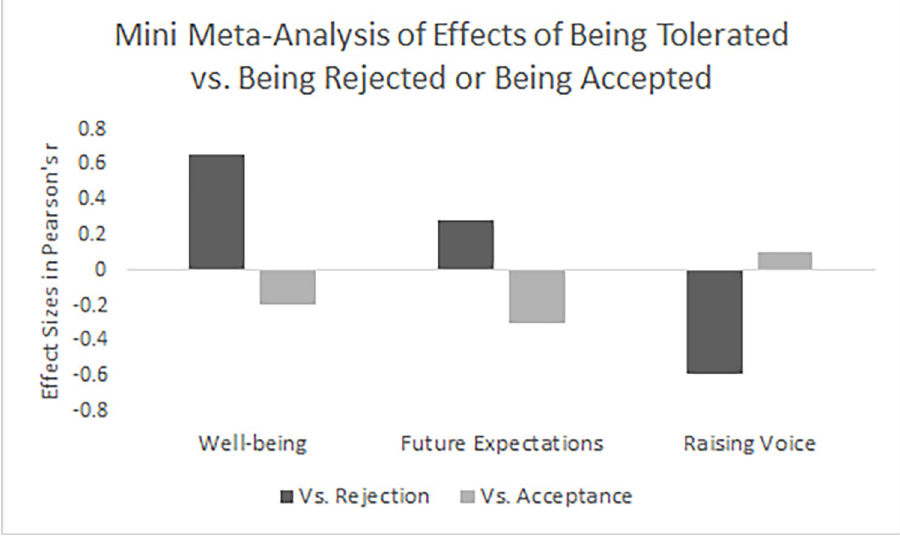
Fig 1. The weighted mean effect sizes of the effect of being tolerated compared to being rejected (dark grey bars) and being accepted (light grey bars) on well-being, future expectations, and raising voice.